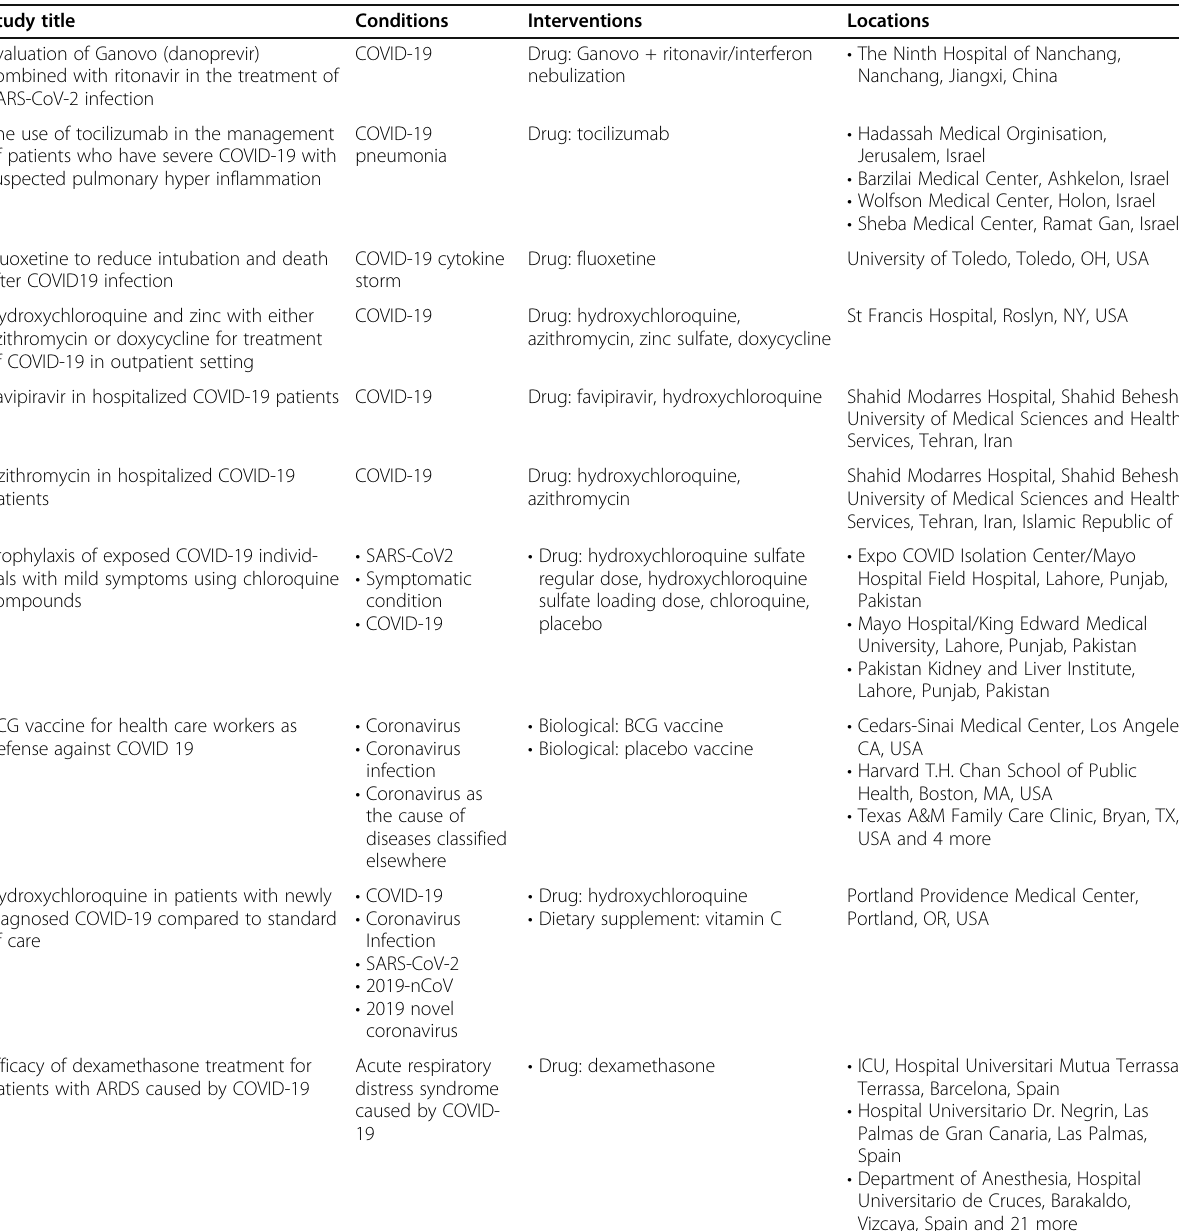
Table 7 Ongoing clinical trials, phase 4